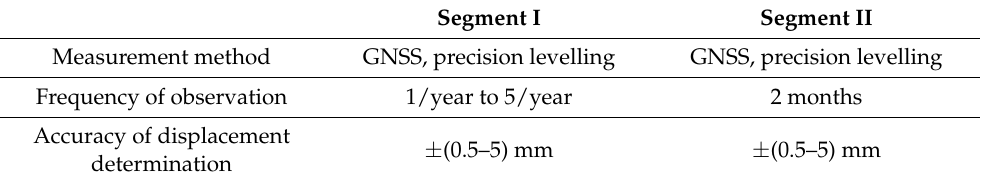
Table 1. Characteristic of a control and measurement system for 3D space testing.